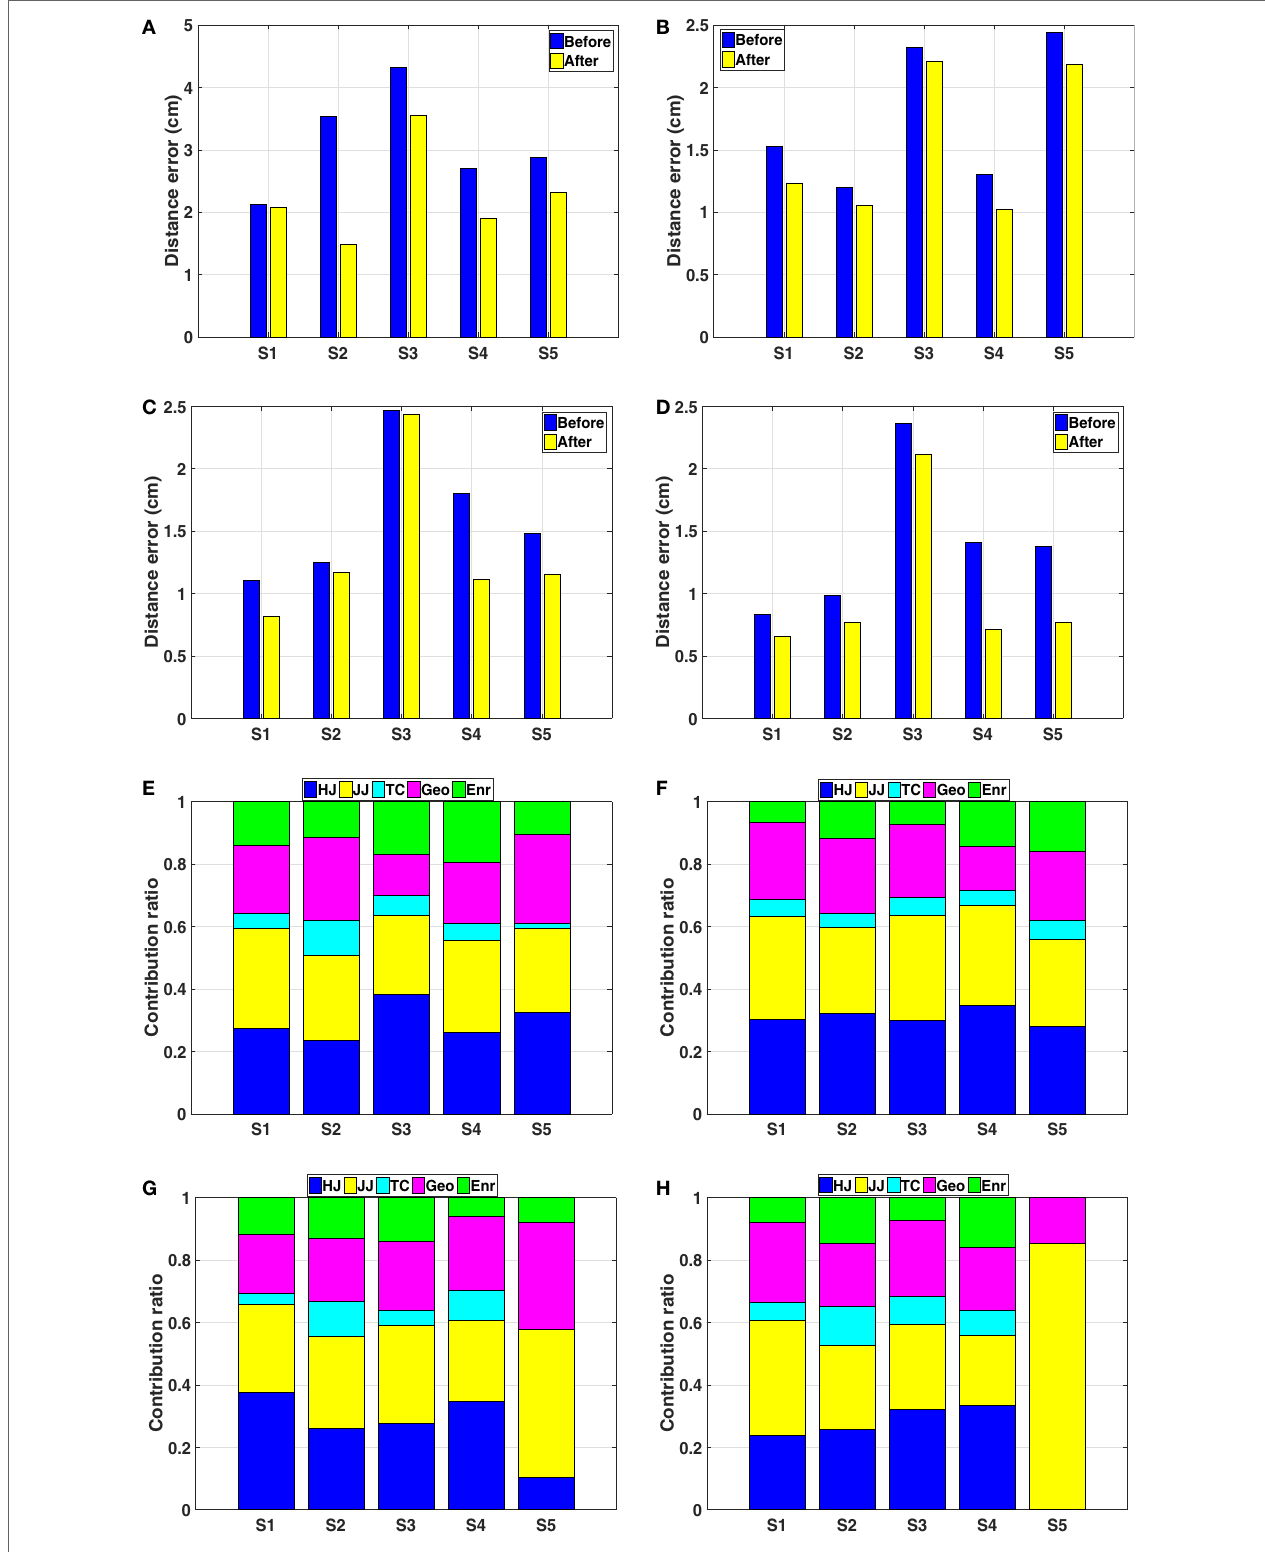
FIGURE 11 | Results of the GPR model updating process. (A–D) The distance error between the optimal trajectories solved with respect to the initial weight vector and the updated weight vector for target one to target four, respectively. (E–H) The contribution of basic cost functions calculated from the mean trajectories of five subjects for target one to target four,